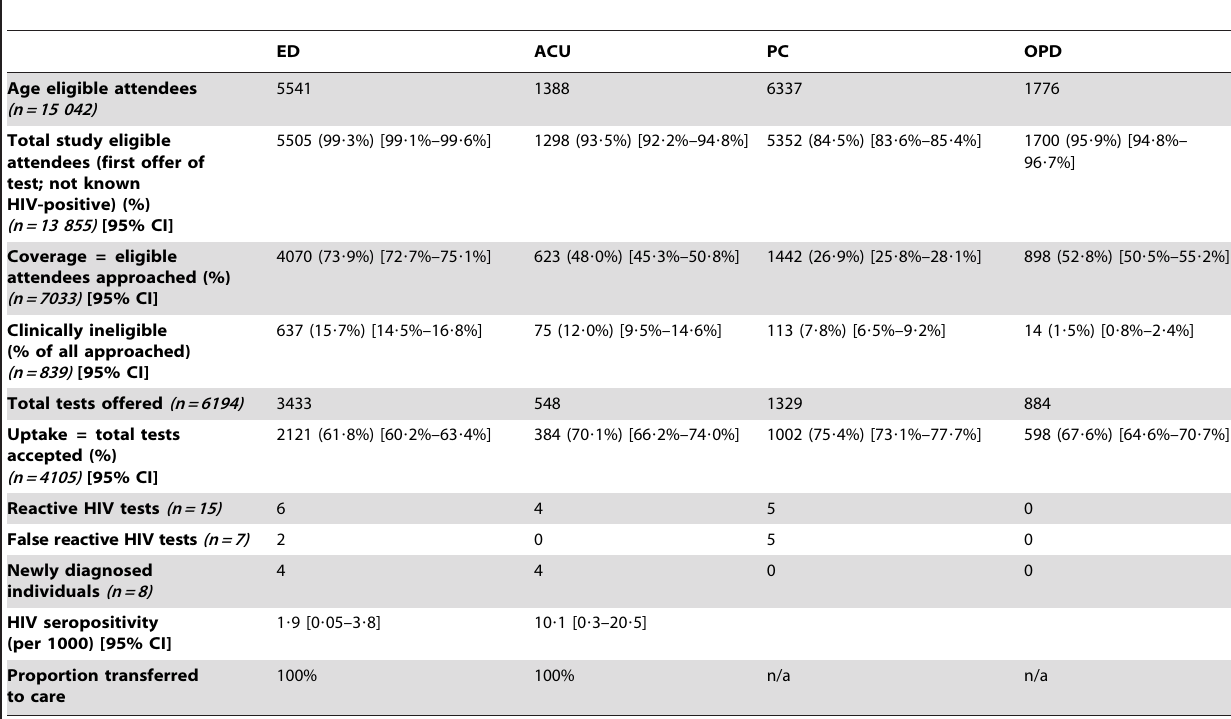
Table 3. Coverage, uptake and seropositivity of routine offer of HIV test across the four sites.